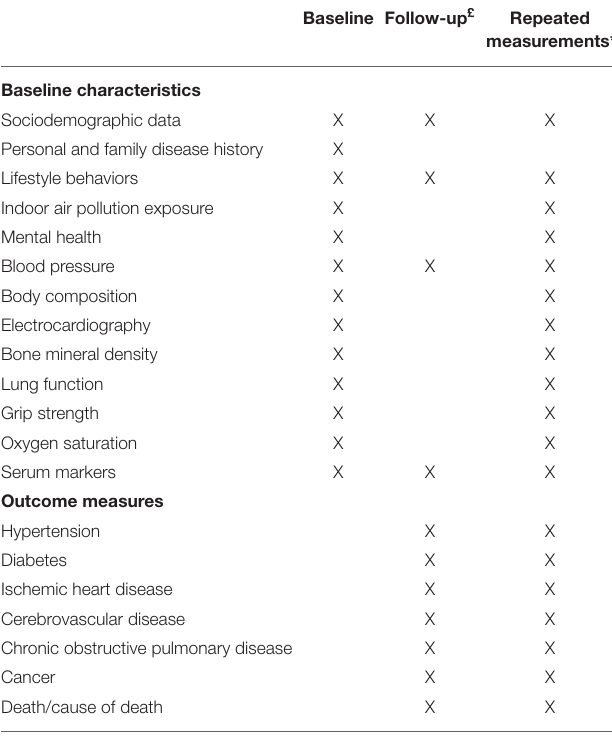
TABLE 1 | Study timeline and assessment of the CHCN-BTH. Baseline Follow-up £ Repeated